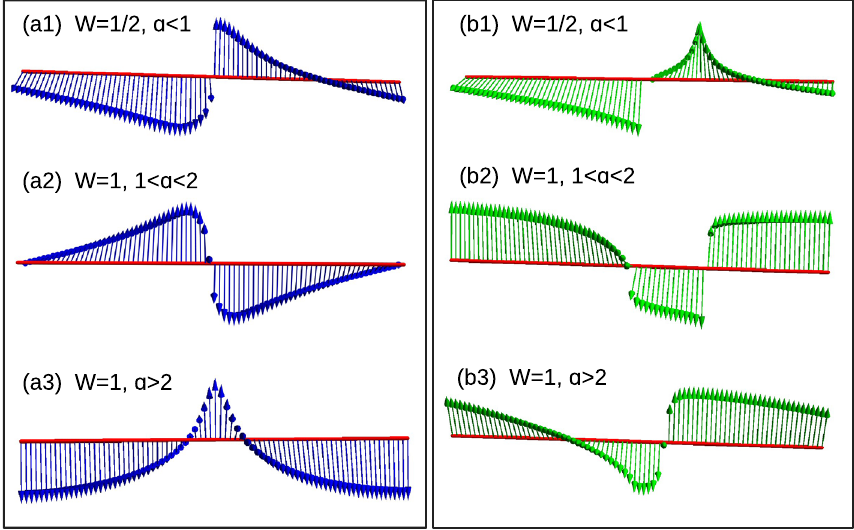
Figure 8. (Color online) Winding vectors representing the topological phases. ( a1 – a3 ) Zero temperature using Eq. (31) ( b1 – b3 ) Very small arbitrary temperature T